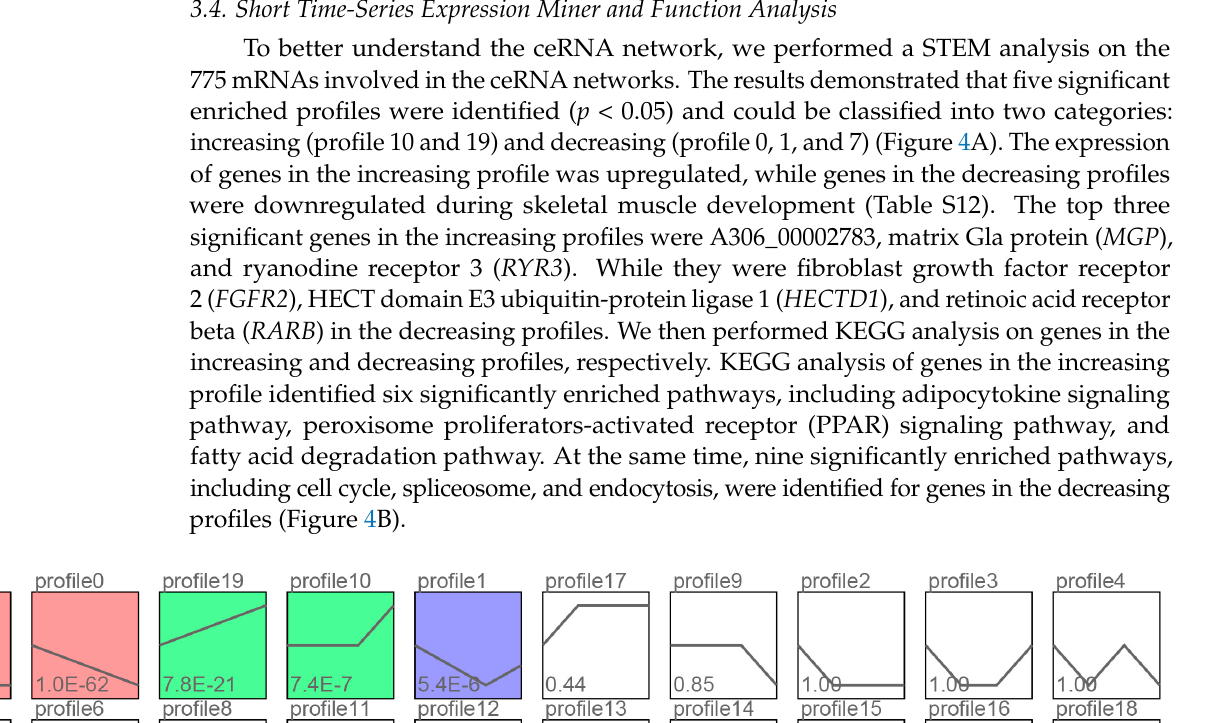
Figure 3. GO and KEGG enrichment analysis of mRNAs involved in the ceRNA network: ( A ) ScatTable 10 significant cellular component terms; ( B ) scatter plot of the top 10 significant molecular function terms; ( C ) scatter plot of the top 10 significant biological process terms; ( D ) scatter plot of the top 10 significant pathways. The node size is proportional to the gene number. The color from red to blue indicates the p -value from low to high.